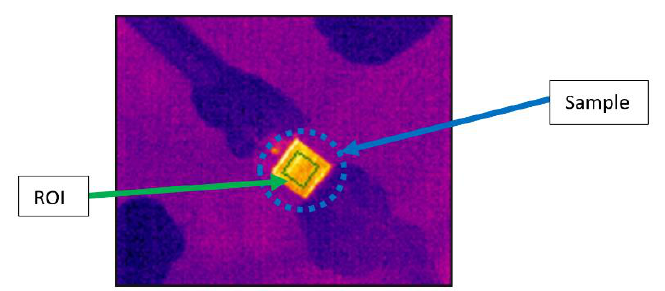
Figure 8. Inconel 601: thermal image and ROI.